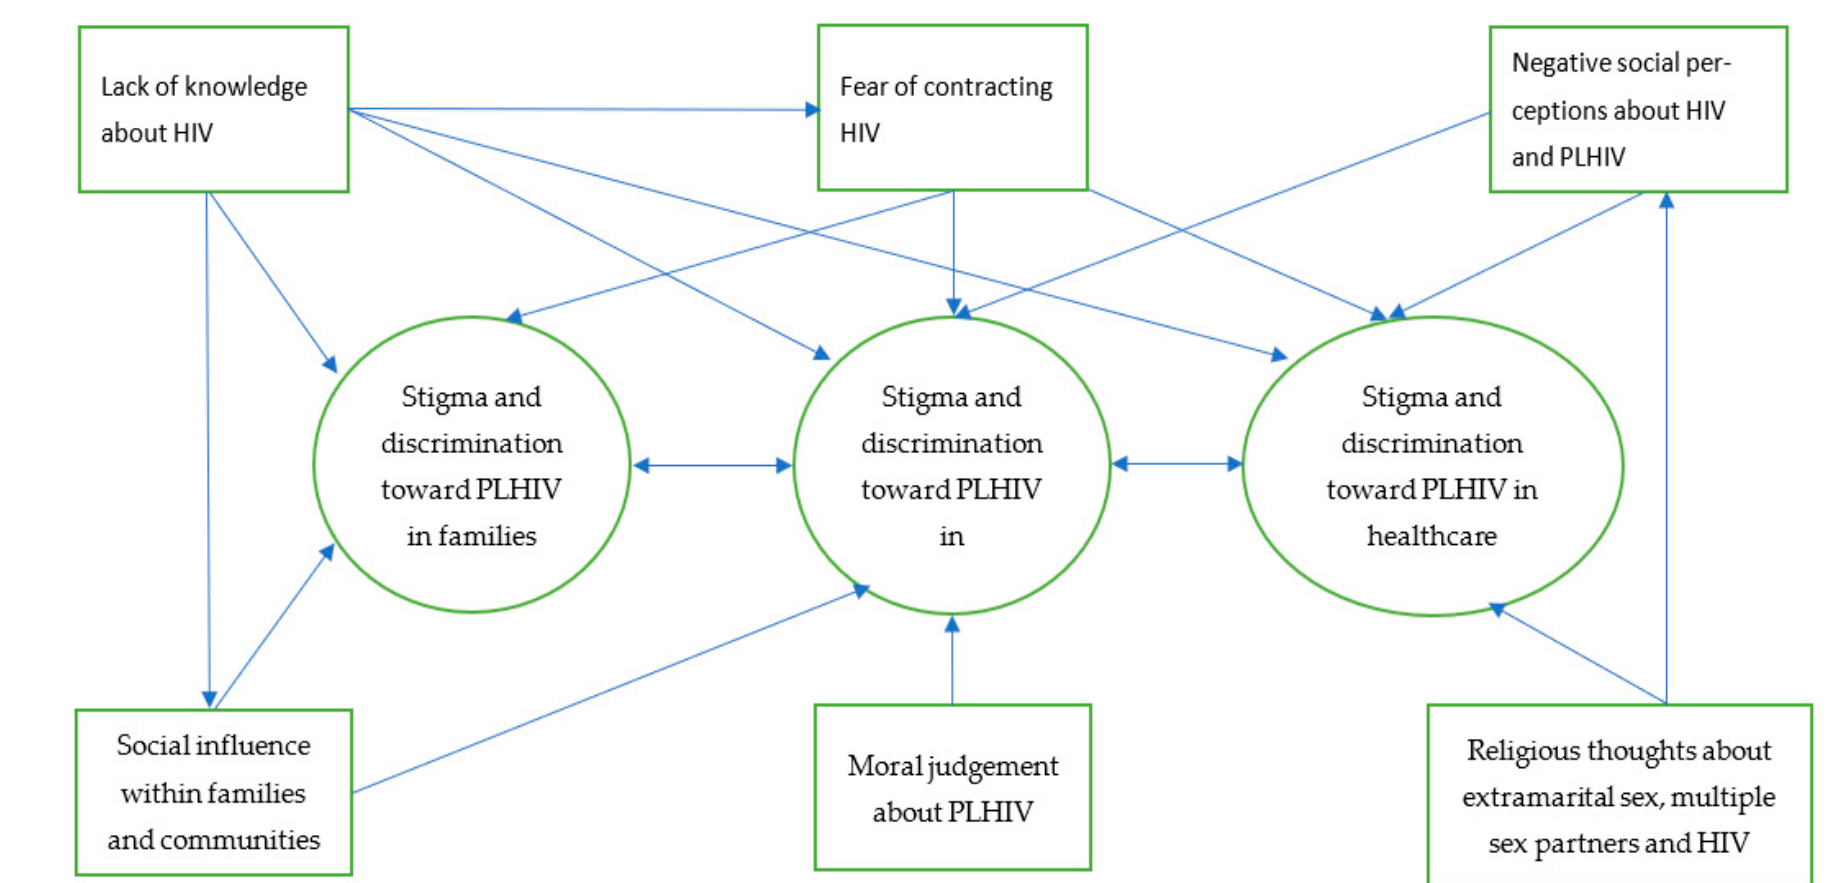
Figure 1. Facilitators or drivers of stigma and discrimination towards PLHIV.